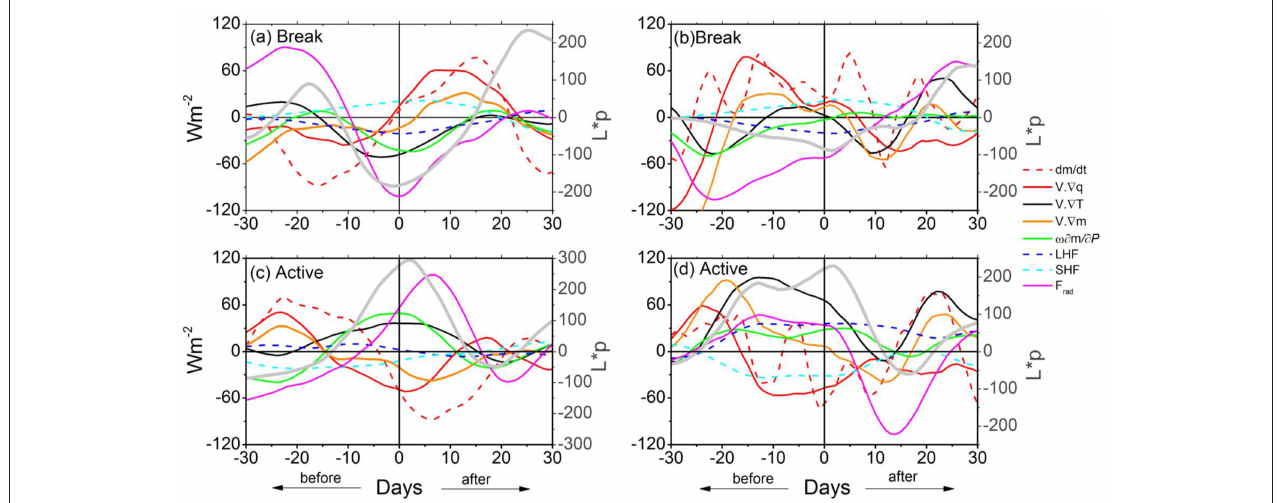
FIGURE 11 | Temporal evolution of various MSE heat budget terms for a typical extended break and active case averaged over NCEN. (a,c) represents the extended break and active phase over NCEN; (b,d) over NCEN for different cases. For completeness of the budget we have superposed precipitation anomalies ( L * p , thick solid gray line; units in Wm − 2 ). The x -axis represents time evolution from − 30 to + 30 days.